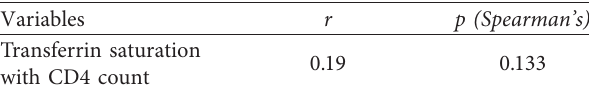
Table 4: Correlation between transferrin saturation with a CD4 cell count in adult patients with transfusion-dependent